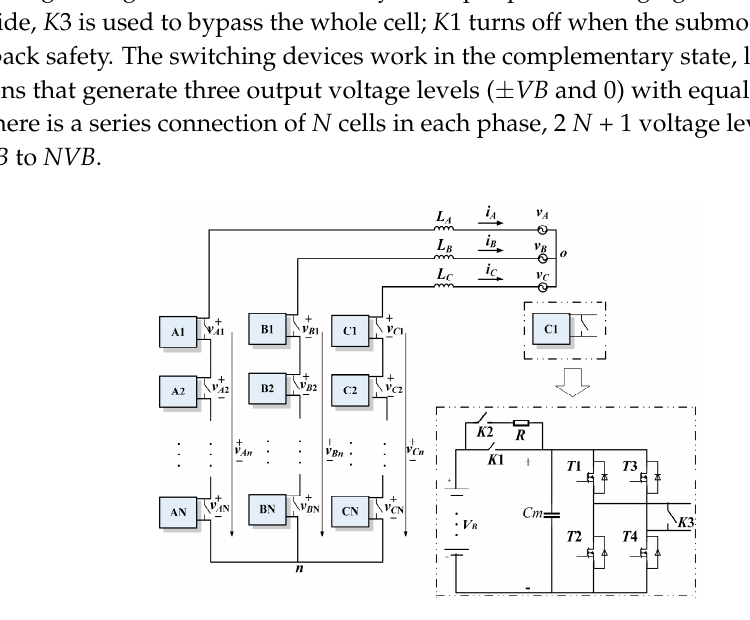
Figure 1. Construction of a flexible group battery energy storage system.